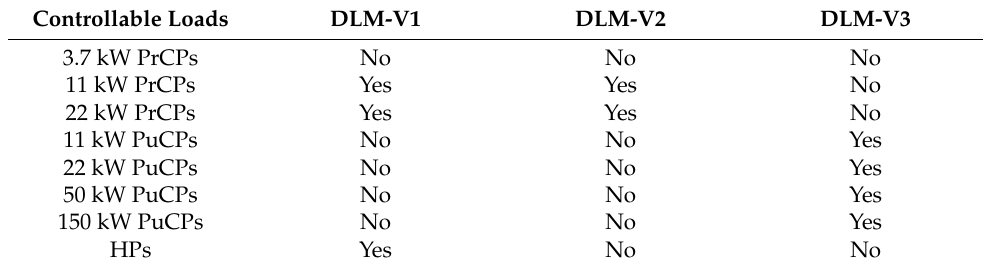
Table 6. Control of the loads within the DLM variants (DLM-V1, DLM-V2, and DLM-V3) [61]. Controllable Loads